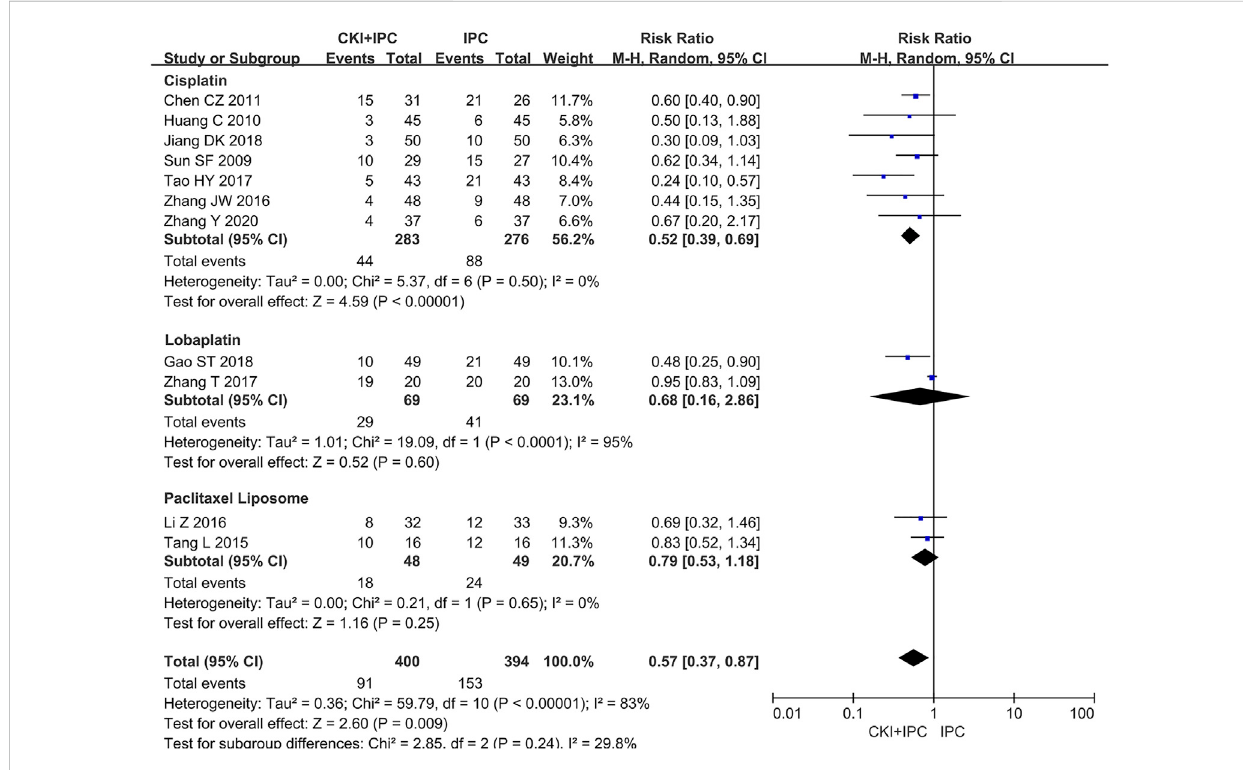
FIGURE 8 Forest plot and pooled risk ratios for the association of gastrointestinal reactions with CKI + IPC and IPC. Subgroup analysis of different chemotherapy